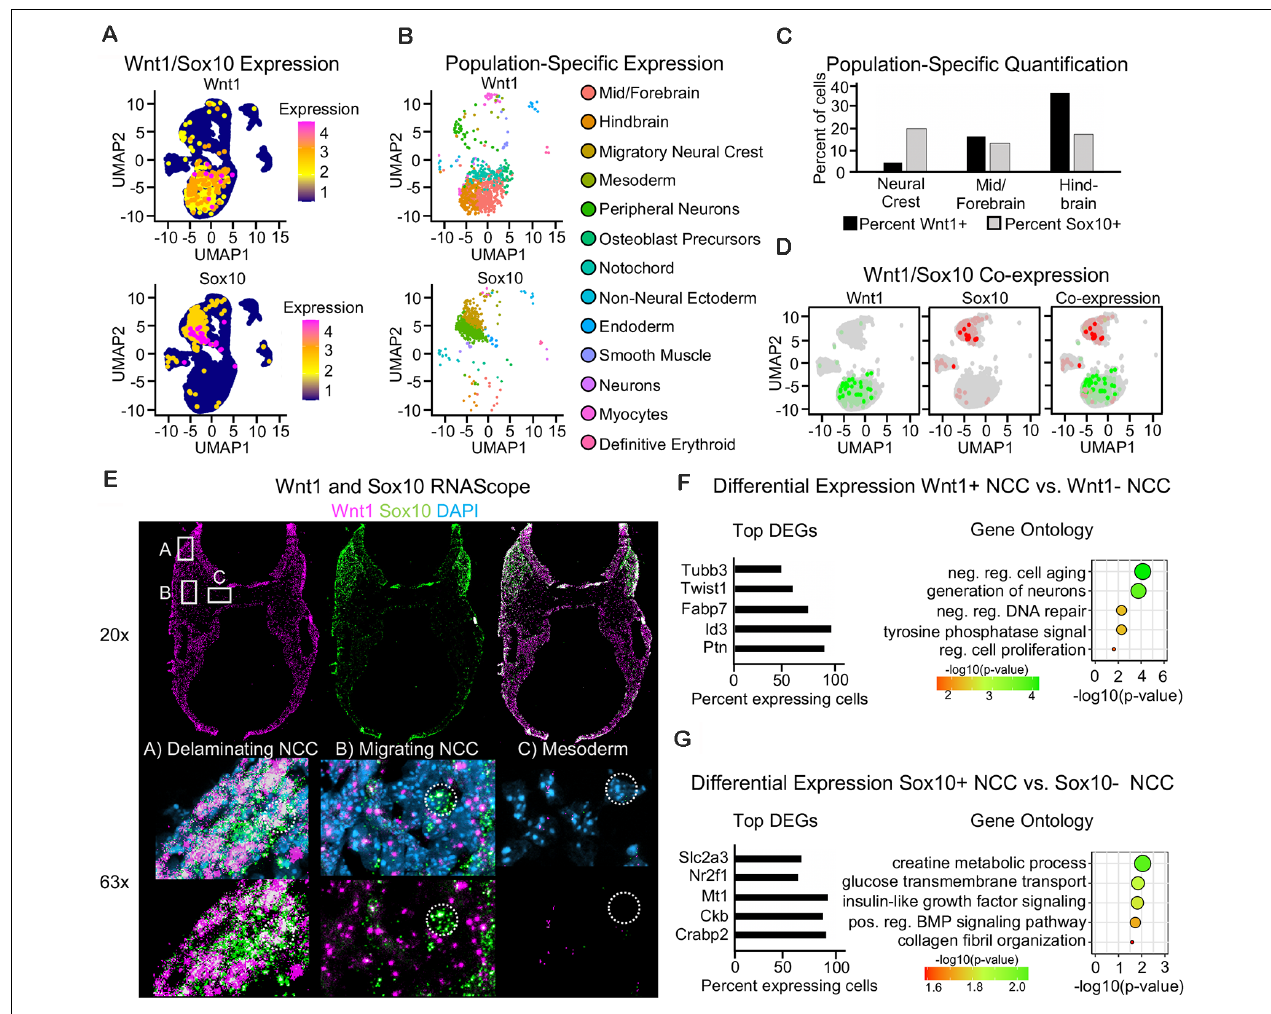
FIGURE 3 | Single-cell sequencing reveals little co-expression of Wnt1 and Sox10 in E9.5 neural crest cells. (A) UMAP plot showing expression of Wnt1 and Sox10 in cells of the E9.5 cranial region. (B) UMAP plot with Wnt1 - and Sox10 -expressing cells colored by cell population. (C) Bar plot of the percent of cells within the neural tube and neural crest expressing Wnt1 or Sox10 . (D) Blended UMAP plot showing little co-expression of Wnt1 and Sox10 . (E) Images of RNAScope for Sox10 and Wnt1 in E9.5 transverse cross-section through the cranial region showing co-localization in the delaminating neural crest, minimal co-localization in the migratory neural crest, and minimal expression of both Wnt1 and Sox10 in cells of the mesoderm. The location of the 63 × image is noted within the 20 × image. (F) Bar plot of differentially expressed genes and GO analysis of Wnt1 -positive cells and (G) Sox10 -positive cells. Categories were ordered by − log10( p -value) and dot size represents − log10( p